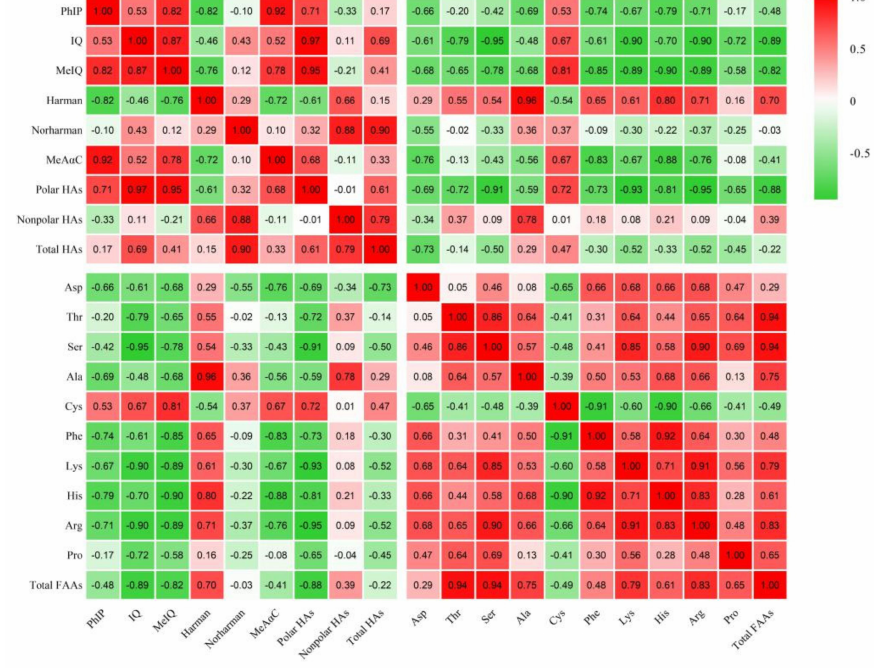
Figure 1. Correlation of HAs and FAAs in roast lamb